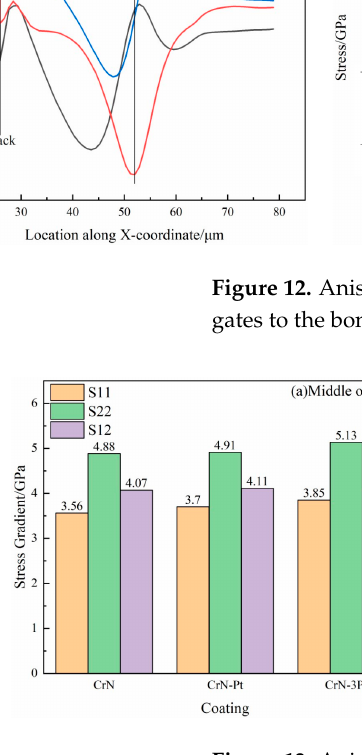
Figure 13. Anisotropic stress gradients of three coating cracks propagating to the coating–substrate interface. ( a ) Middle of crack; ( b ) Crack tip.